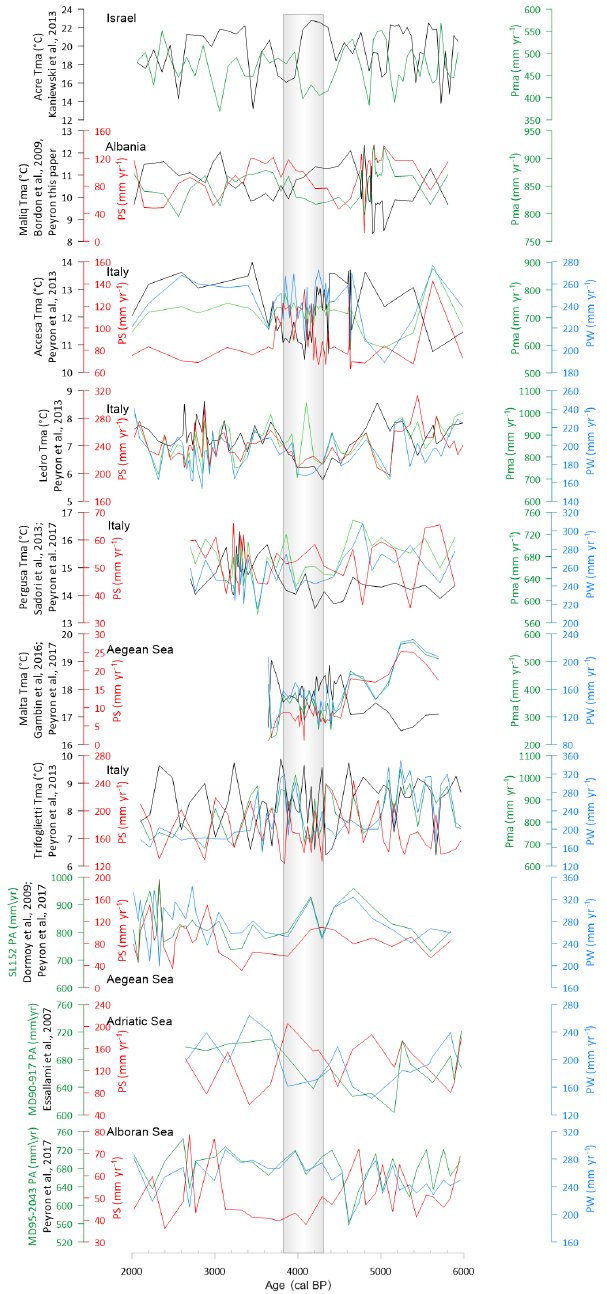
Figure 5. Selected temperature ( T , ◦ C) and precipitation ( P , mmyear − 1 ) records obtained from pollen records. Tma: mean an- nual temperature; Pma: mean annual precipitation; PS: average summer precipitation; PW: average winter precipitation. For loca- tion, refer to Fig. 1 and for references to Table